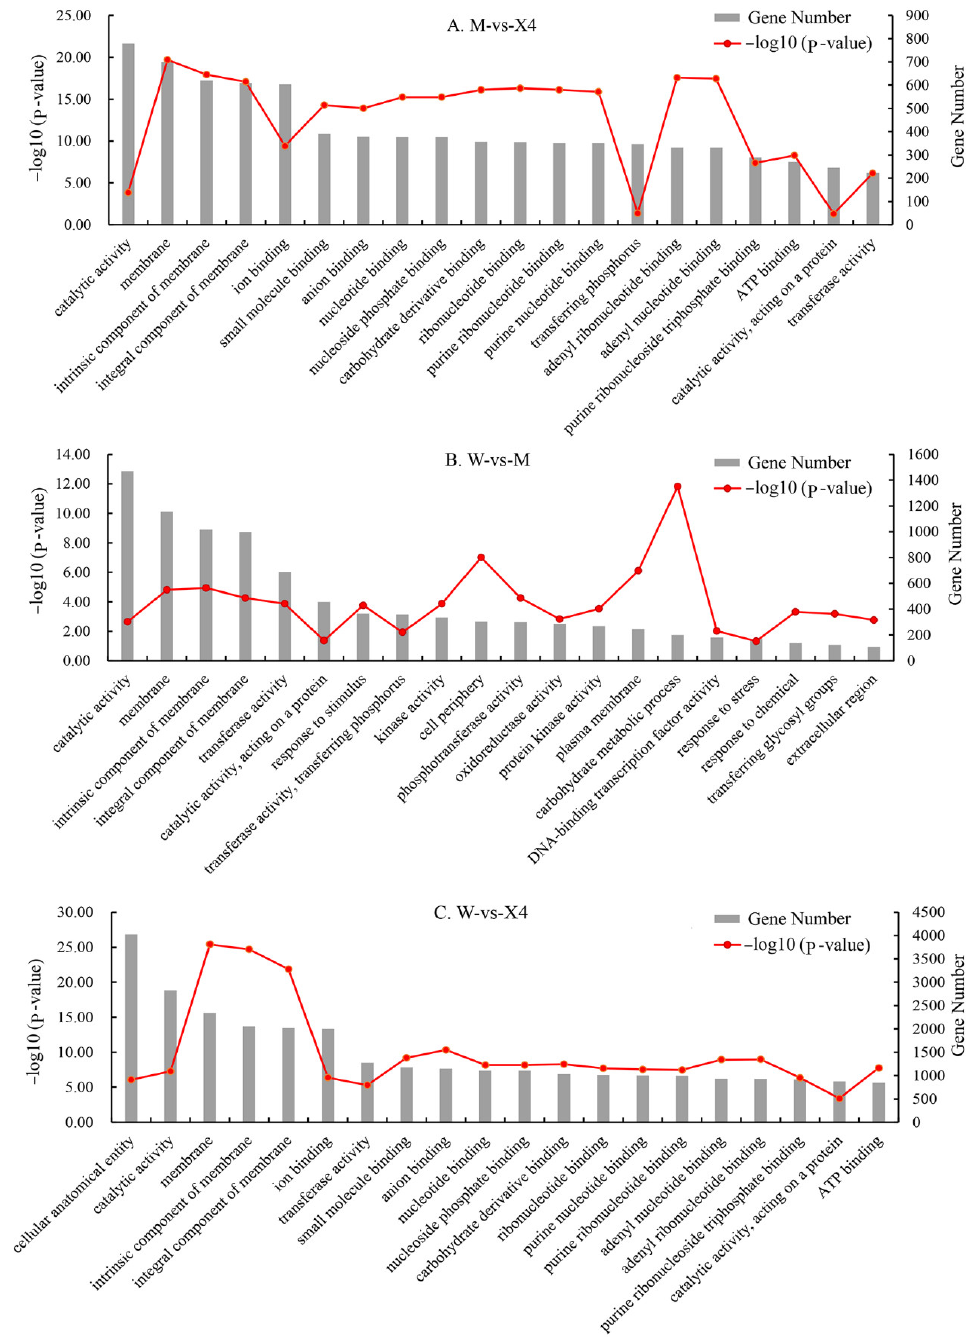
Figure 4. GO pathway analysis of differentially expressed genes. X -axis represents GO terms, left Y -axis represents p -value of specific GO term [expressed as − log10 ( p -value)], right Y -axis represents number of DEGs of each GO pathway.